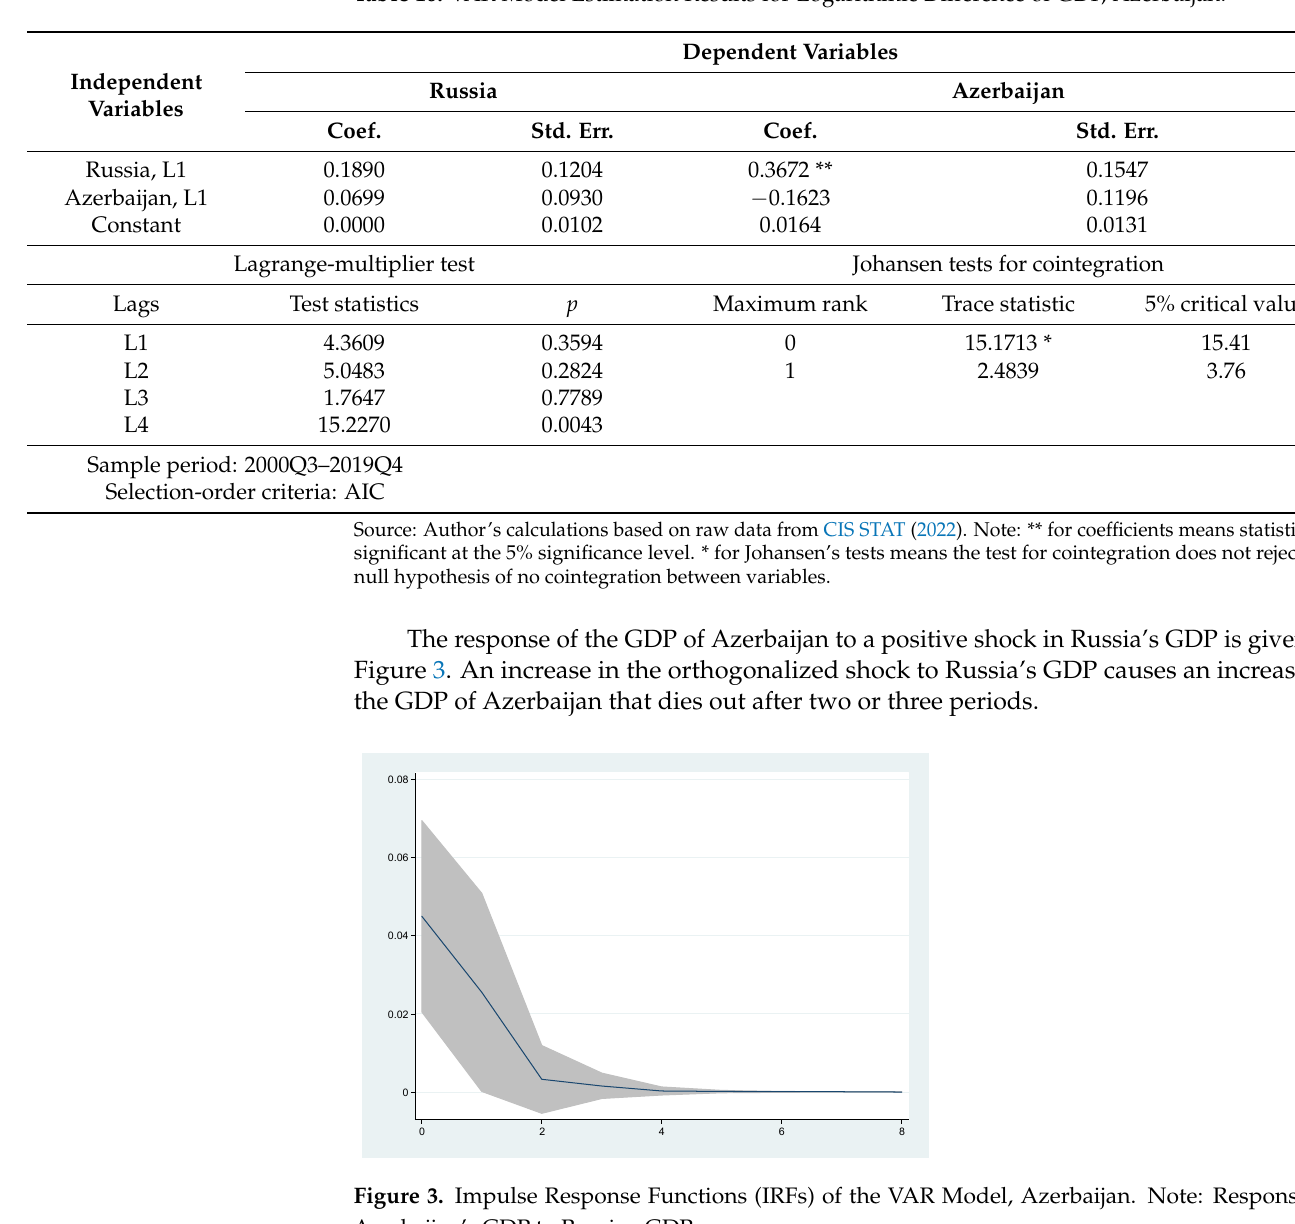
Table 10. VAR Model Estimation Results for Logarithmic Difference of GDP, Azerbaijan.